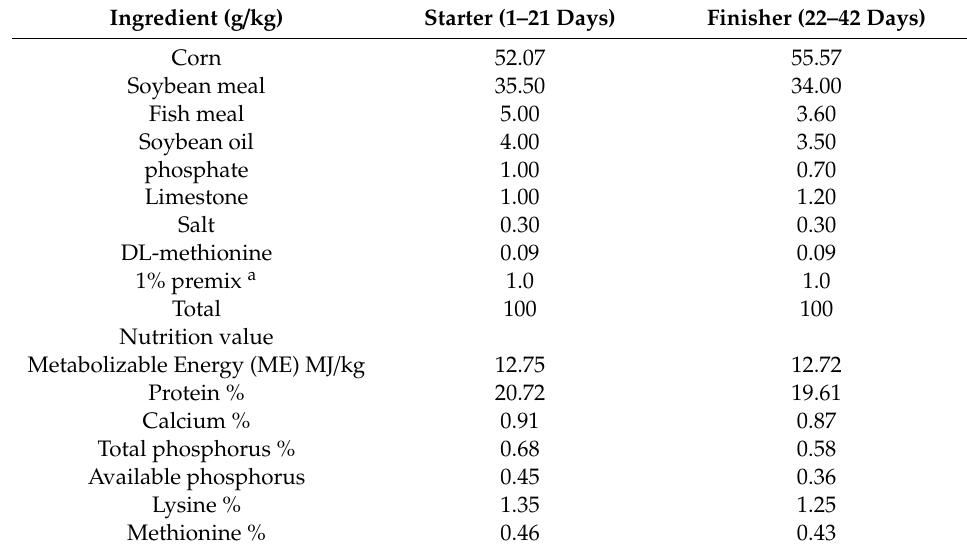
Table 1. Ingredients and nutrient levels of the basal starter (1–21 days) and finisher (22–42 days) diets (on dry matter basis) used in experiments 1 and